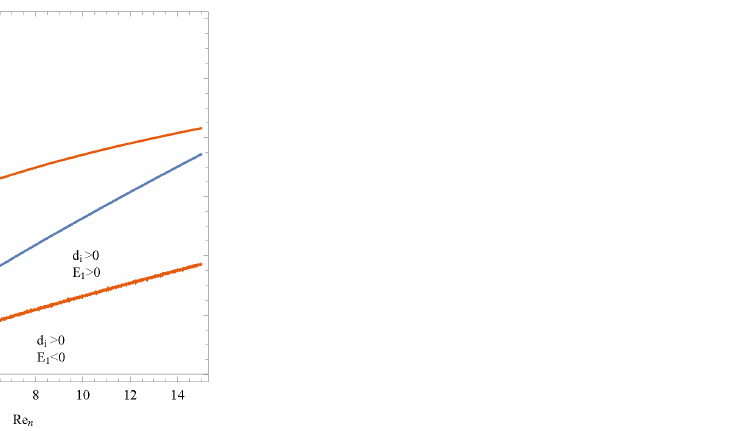
Fluids 2022 , 7 , x 11 of 15 The regions of Figure 5–7 are separated by the blue curves and orange curves. The blue curve is d i =0. The orange curve is E 1 =0. Figure 6 shows the result of the growth am ‐ plitude of the Newtonian fluid film flowing down along a vertical static plane. This figure is separated into four parts which are the four types of the condition by the curve d i = 0 and E 1 = 0. By comparing the results of Figure 5, n = 1.05 Z = 0.51, and Figure 7, n = 0.95 Z = − 0.32, with Figure 6, the following can be concluded: the regions of sub ‐ critical instability and absolute stability are expanded; meanwhile, the parts of supercritical stability and explosive supercritical instability are compressed when the plane moves downward, Z >